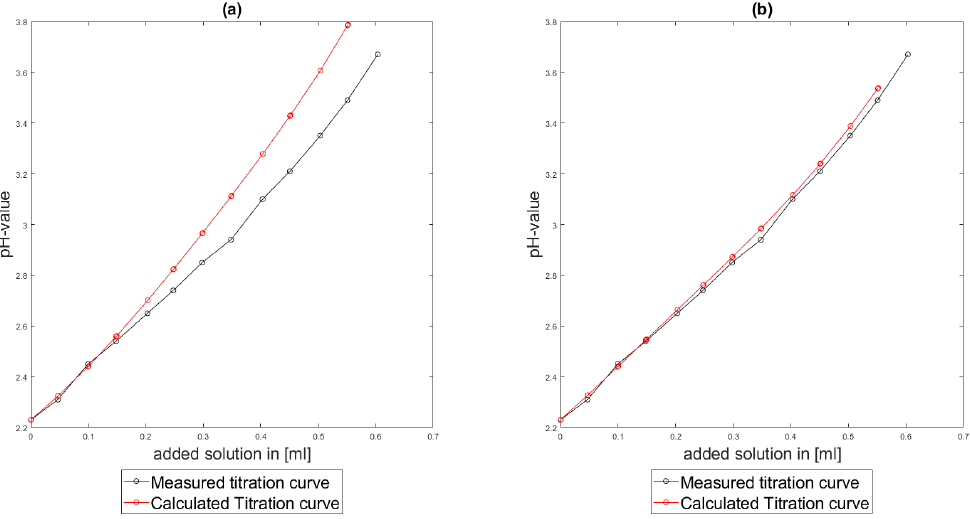
Figure 15. ( a ) Comparison of predicted, with parameters given in Table 8, and expected Cit-Ni titration curve calculated titration curves, for the given Cit-Ni electrolyte. ( b ) Comparison of expected and optimized titration curves. The results of the optimization can be found in Table